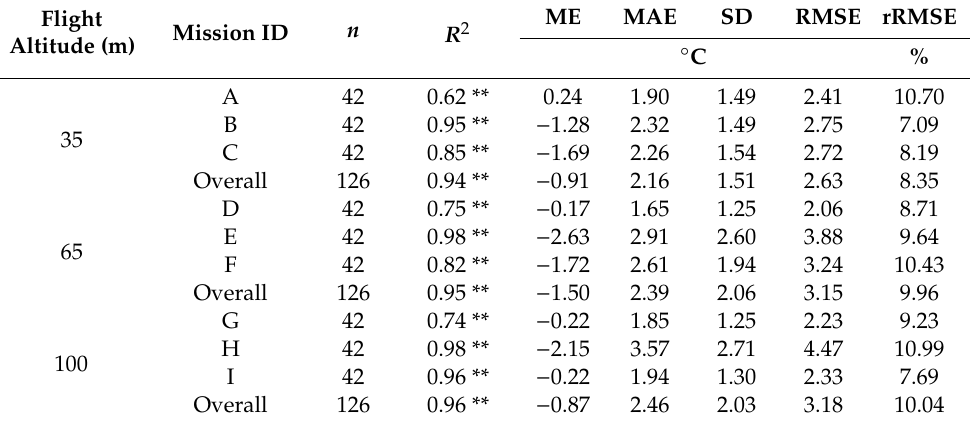
Table 3. Relationship and residuals between TIR measurements and reference temperature for aerial conditions according to flight altitudes tested. n = number of samples; R 2 = coe ffi cient of determination; RMSE; p -value < 0.001